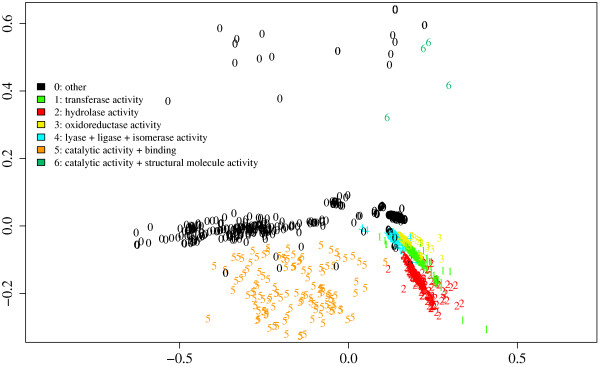
2D-Multidimensional scaling plot colored according to the type of "catalytic activity" of the proteins. Proteins annotated with a descendant are colored according to the type of their catalytic activity. One elongated region corresponds to "transferase activity" (1), another to "hydrolase activity" (2), and another region to "oxidoreductase activity" (3). Proteins annotated with "lyase activity", "ligase activity", or "isomerase activity" (4) are mostly located along the top of the whole "catalytic activity" region.